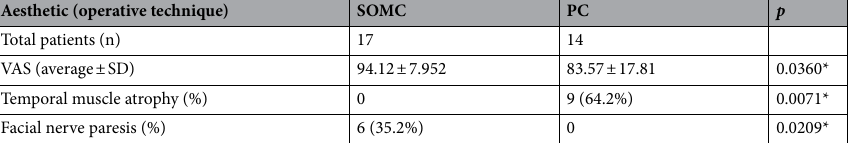
Table 3. Results of aesthetic evaluation of patients who underwent supraorbital minicraniotomy (SOMC) and pterional craniotomy (PC). VAS Visual Analog Scale, SD standard deviation. *Significant. Unpaired Student’s t test.